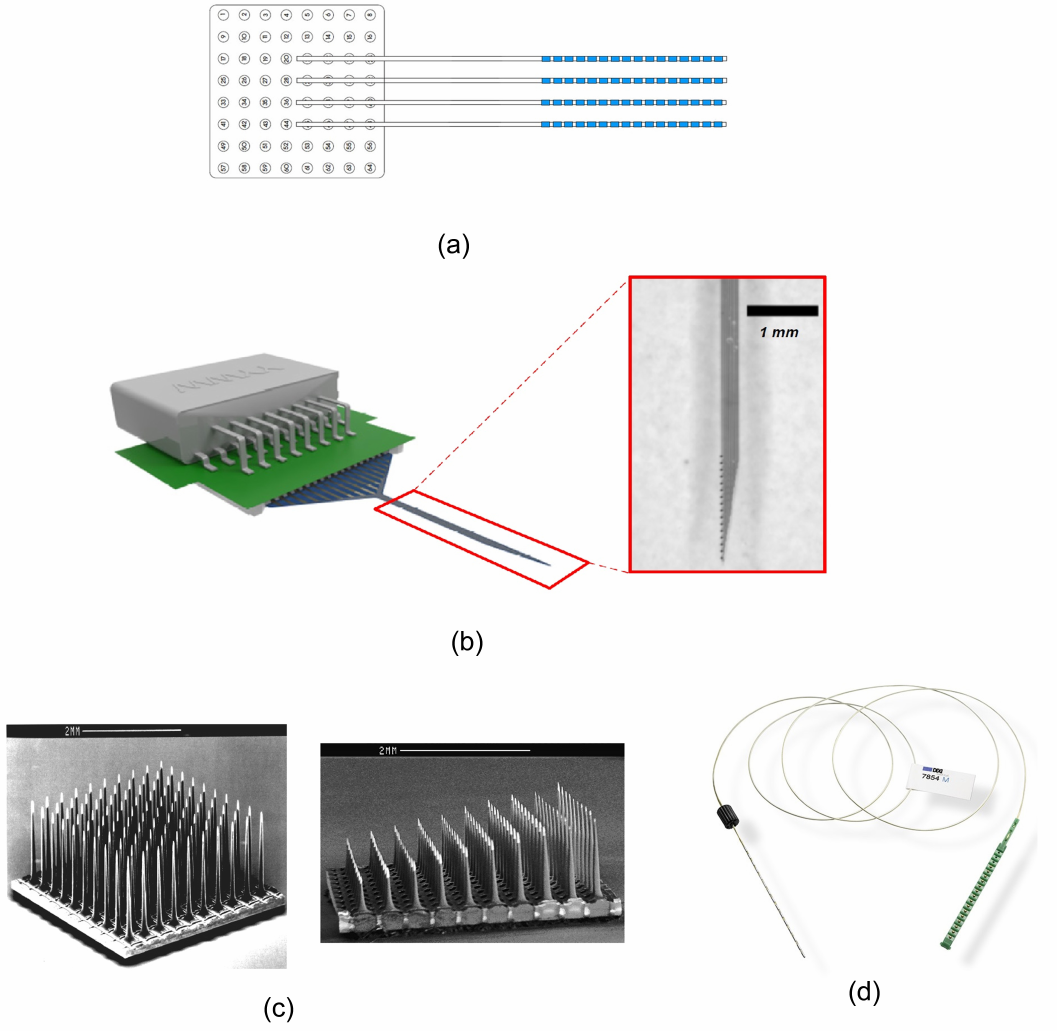
Figure 7. Different types of electrodes for neural recording including ( a ) grid array for intradural or subdural recording, ( b ) laminar intracortical electrodes, ( c ) intracortical micro-electrode array (Reprinted with permission of Wiley Periodicals, Inc., © 2003 The American Laryngological, Rhinological and Otological Society, Inc.), [38]) and ( d ) SEEG electrode (Courtesy DIXI